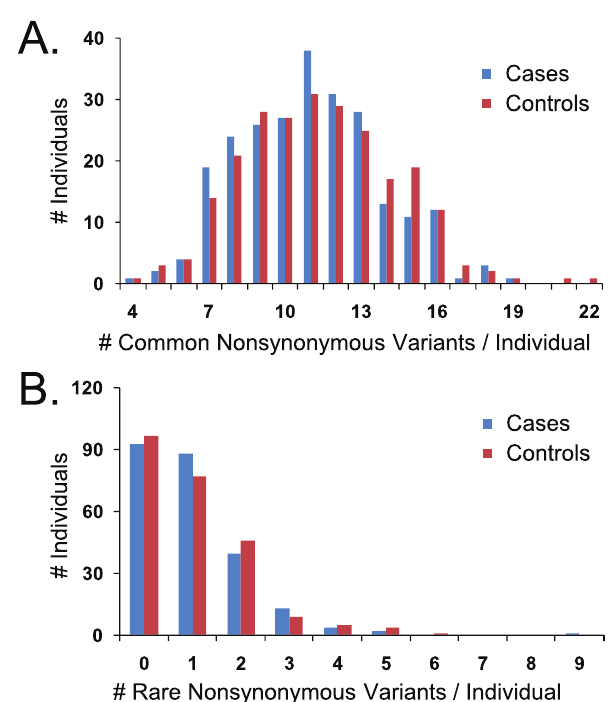
Table 1. Numbers of Variants Indentified by Category.